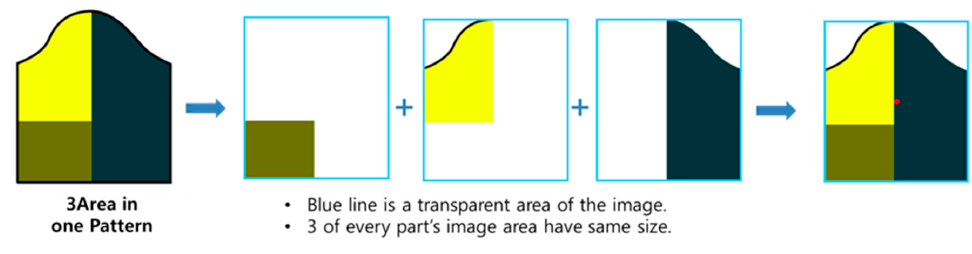
Figure 14. Example of one pattern with one more area.